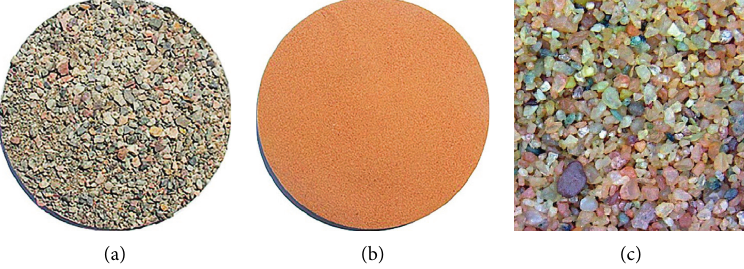
Figure 1: Appearance characteristics of fine aggregate. (a) Artificial washing sand. (b) DS. (c) DS (50 × ).